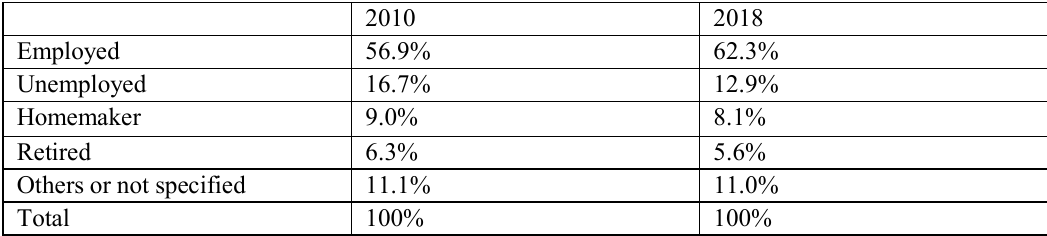
Table 8: Proportions of adults with different employment status among the low-literate population 2010 2018 Employed 56.9% 62.3% Unemployed 16.7% 12.9% Homemaker 9.0% 8.1% Retired 6.3% 5.6% Others or not specified 11.1% 11.0% Total 100%